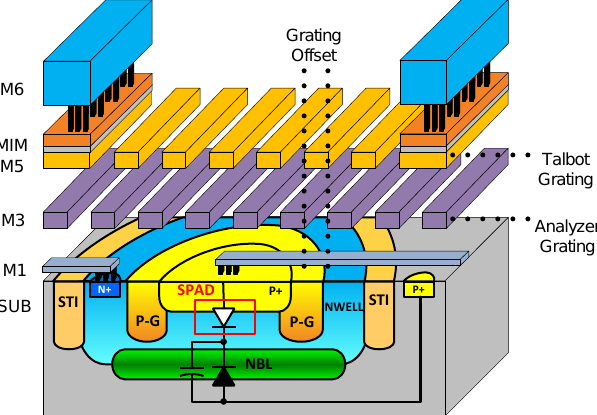
Figure 3. A cross-section of the proposed angle-sensitive single photon avalanche diode (A-SPAD) structure. Reproduced from [22], with the permission of AIP Publishing.